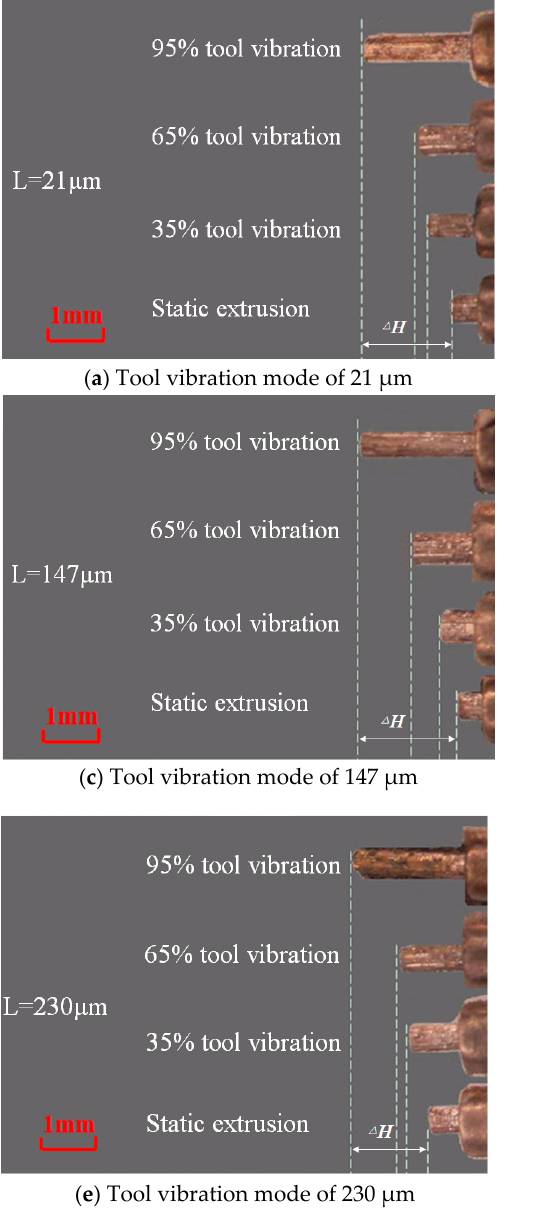
Figure 7. Micro-extrusion lengths with di ff erent ultrasonic power outputs.